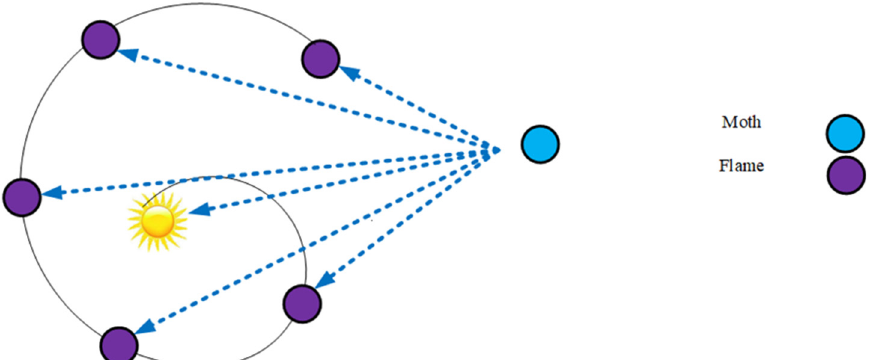
Figure 3. The flight path of moths.